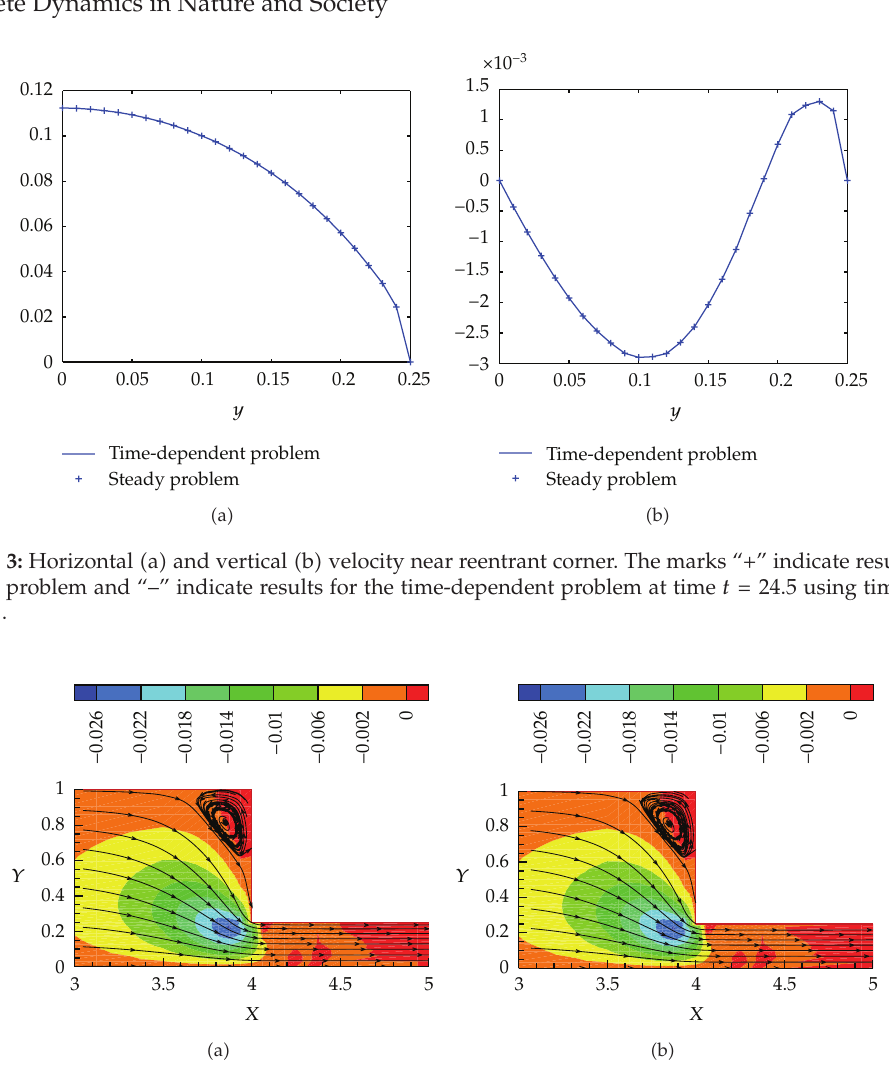
Figure 4: Streamlines and magnitude of velocity contours for u . (cid:2) a (cid:3) : steady problem, (cid:2) b (cid:3) : time-dependent problem at time t (cid:9) 24 . 5 using k (cid:9) 0 .